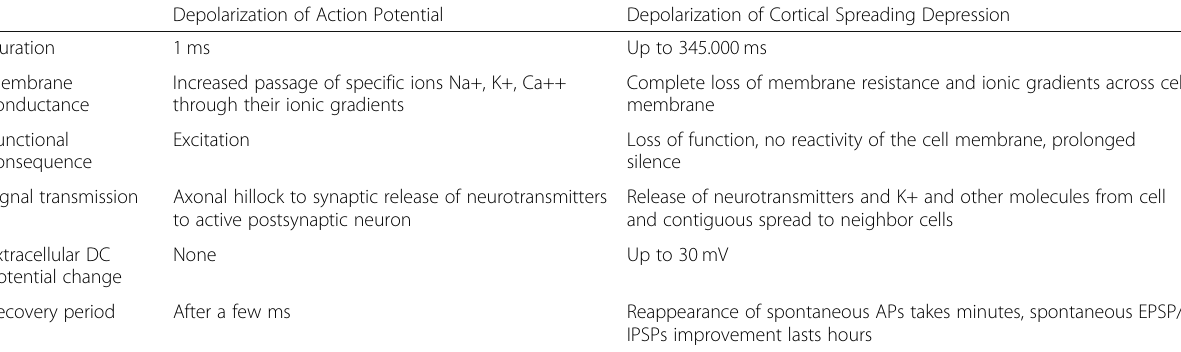
Table 1 Distinguishing features of depolarizations of action potentials and cortical spreading depression Depolarization of Action